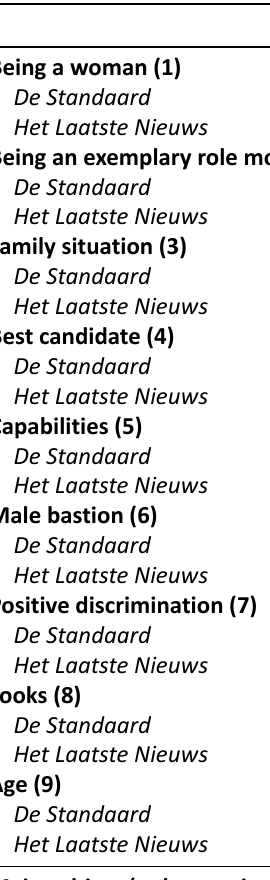
Table 2. Total number of articles mentioning the specific labels in the selected news articles about Catherine De Bolle and Dominique